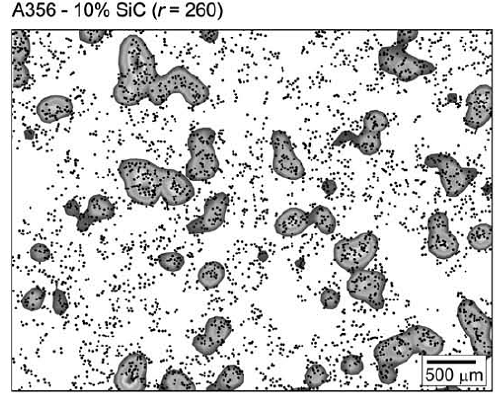
Figure 21. Kernels associated with above-threshold particles for SiC-Al alloy composite